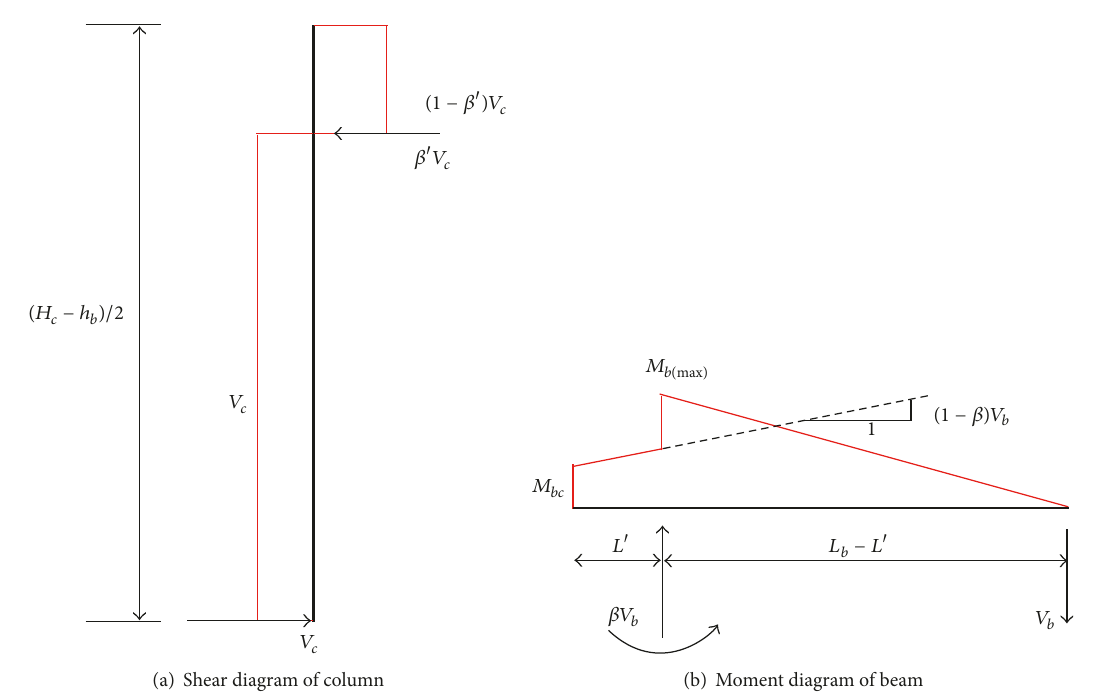
Figure 15: Shear and moment diagram of beam-column joints retrofitted by haunch elements